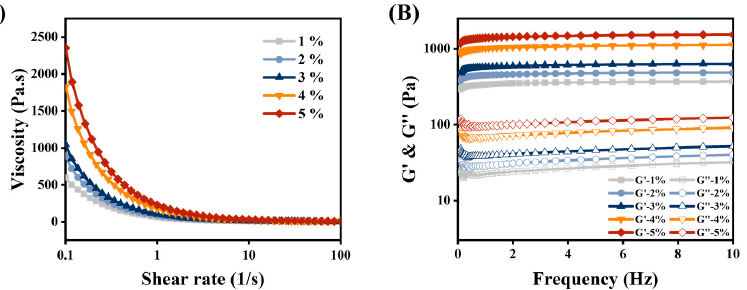
Figure 3. ( A ) Strain sweeps and ( B ) frequency sweep of HIPEs stabilized by 1–5 wt% MPPI.